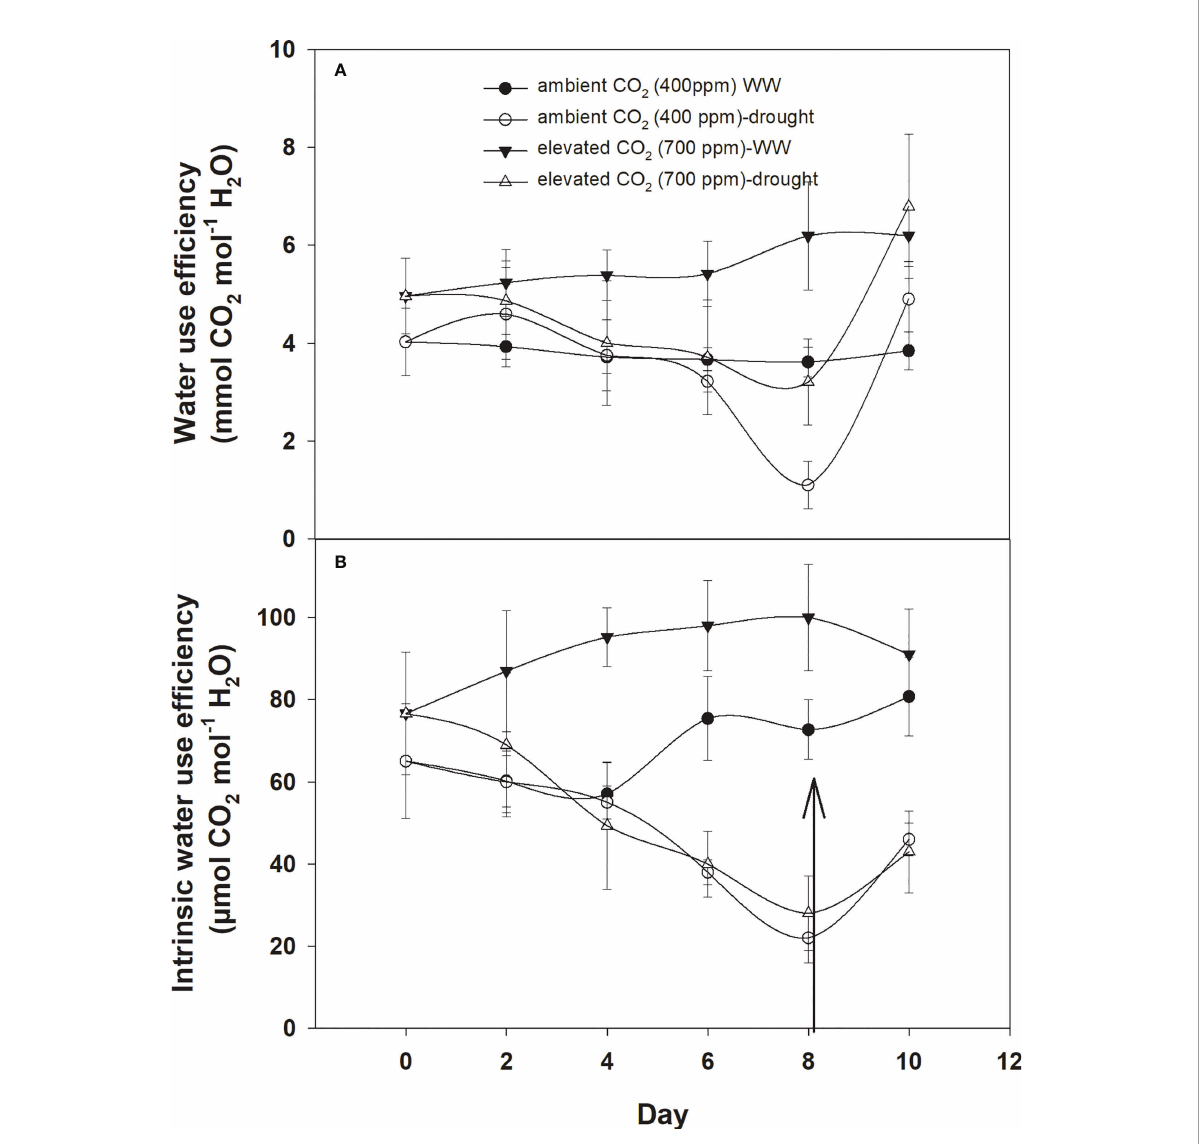
FIGURE 3 Effect of CO 2 concentrations and moisture conditions on (A) water use ef fi ciency and (B) intrinsic water use ef fi ciency of Datura stramonium . The vertical line on the data point represents the standard error of the mean and the vertical arrow line after Day 8 represents the addition of water in the drought treatments. WW,